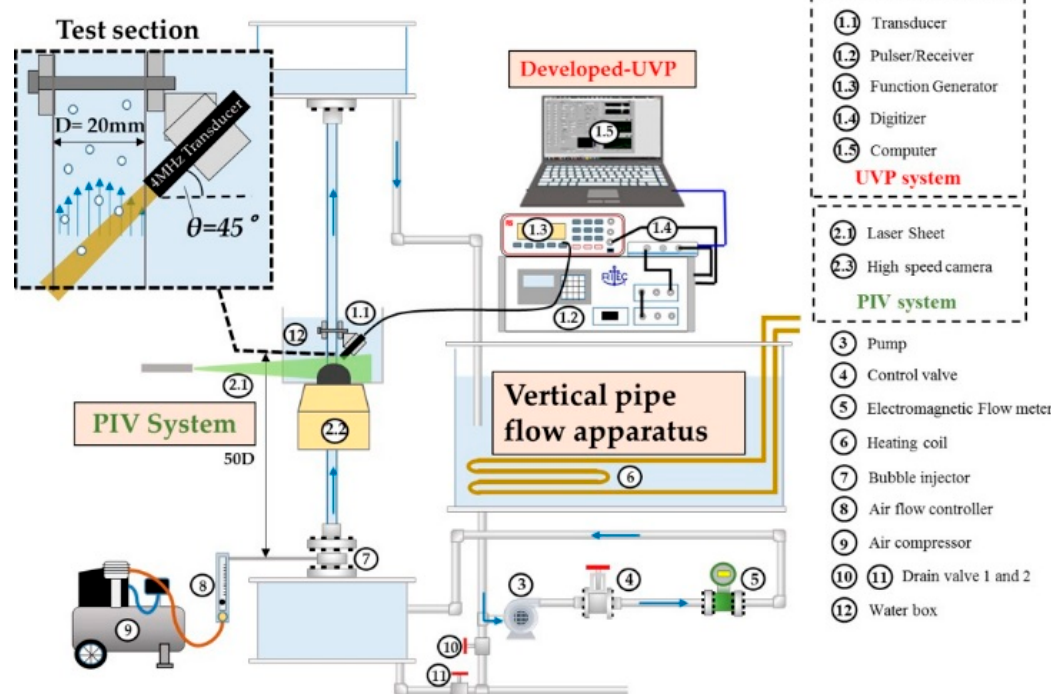
Figure 10. Schematic of the experimental apparatus.